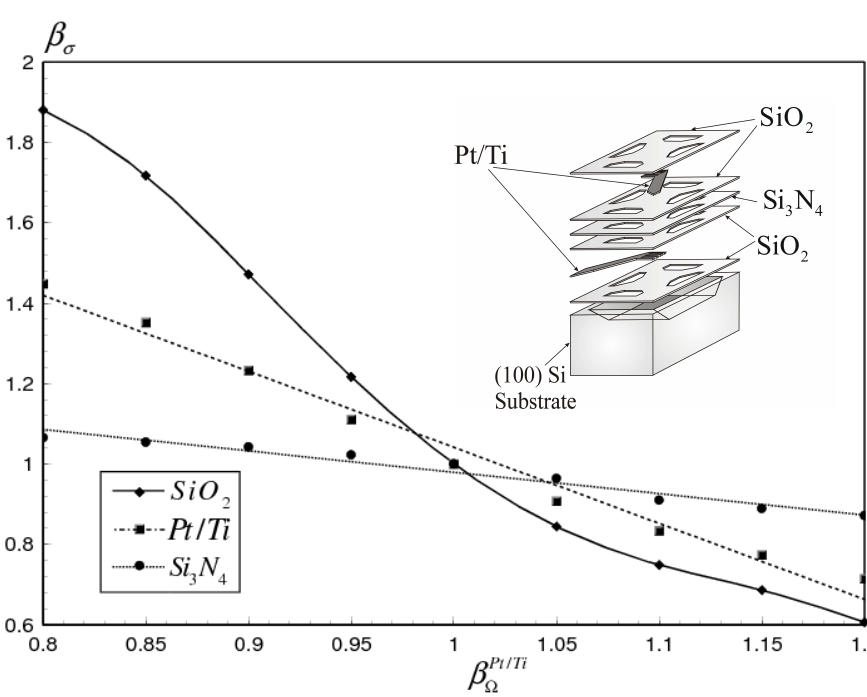
Figure 6. Effect of electrical resistivity variation of Pt/Ti on the maximum thermal stress of different gas sensor materials